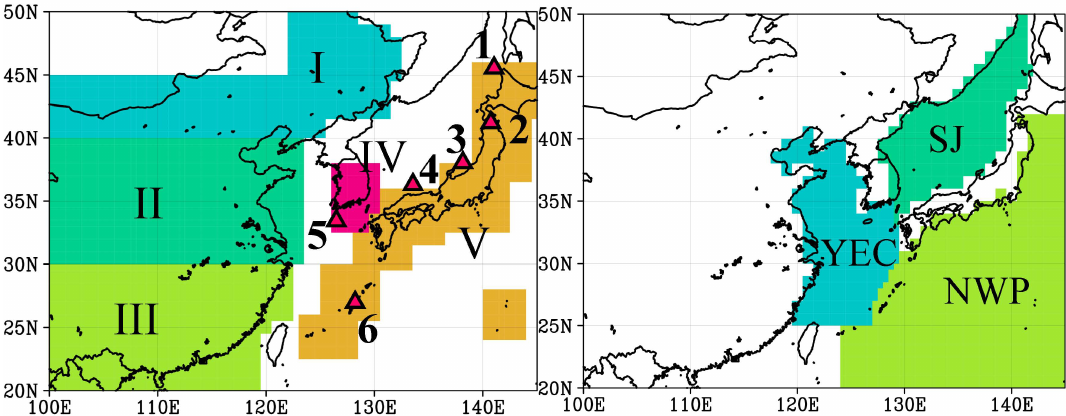
Fig. 1. The model domain and the EANET remote monitoring stations (1–6, pink triangle): 1. Rishiri, 2. Tappi, 3. Sado, 4. Oki, 5. Jeju, and 6. Hedo. Descriptions of the locations are given in Table 1. The color shaded areas (left) I to V represent regions for source-receptor relationship analyses, I: North China ( > 40 ◦ N), II: Central China ( > 30 ◦ N, < 40 ◦ N), III: South China ( < 30 ◦ N), IV: South Korea, and V: Japan. The areas on the right represent oceanic receptor areas, YEC: Yellow Sea and East China Sea, SJ: Sea of Japan, and NWP: Northwest Pacific